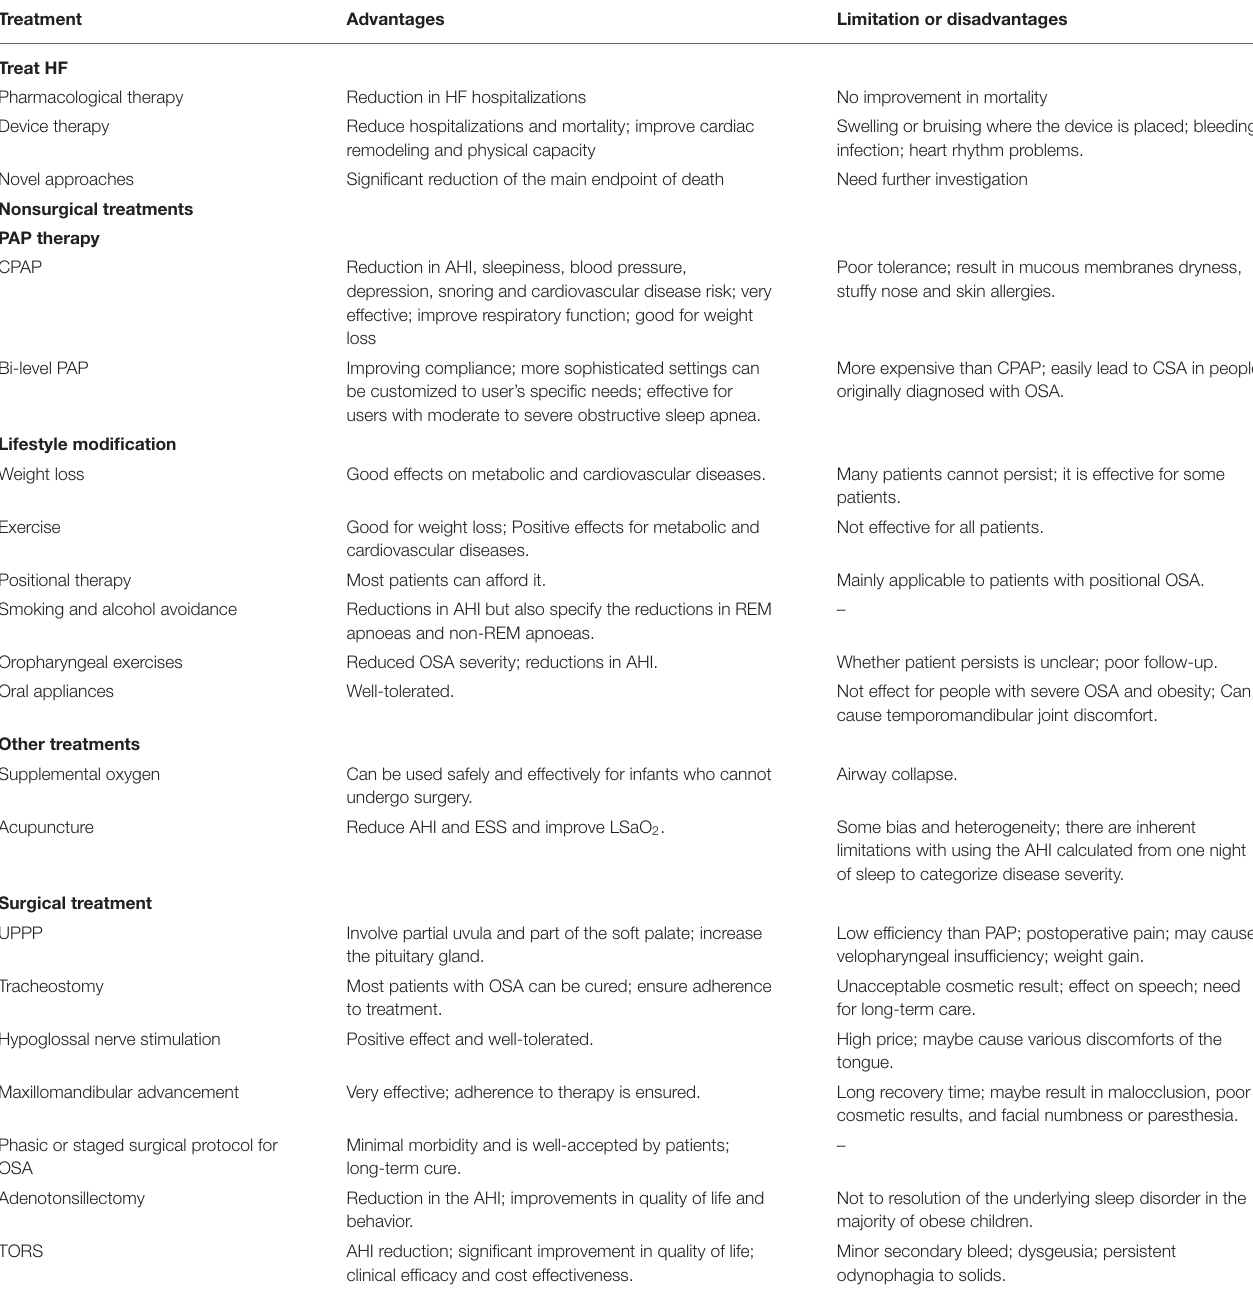
TABLE 1 | Current treatments for patients with OSA and